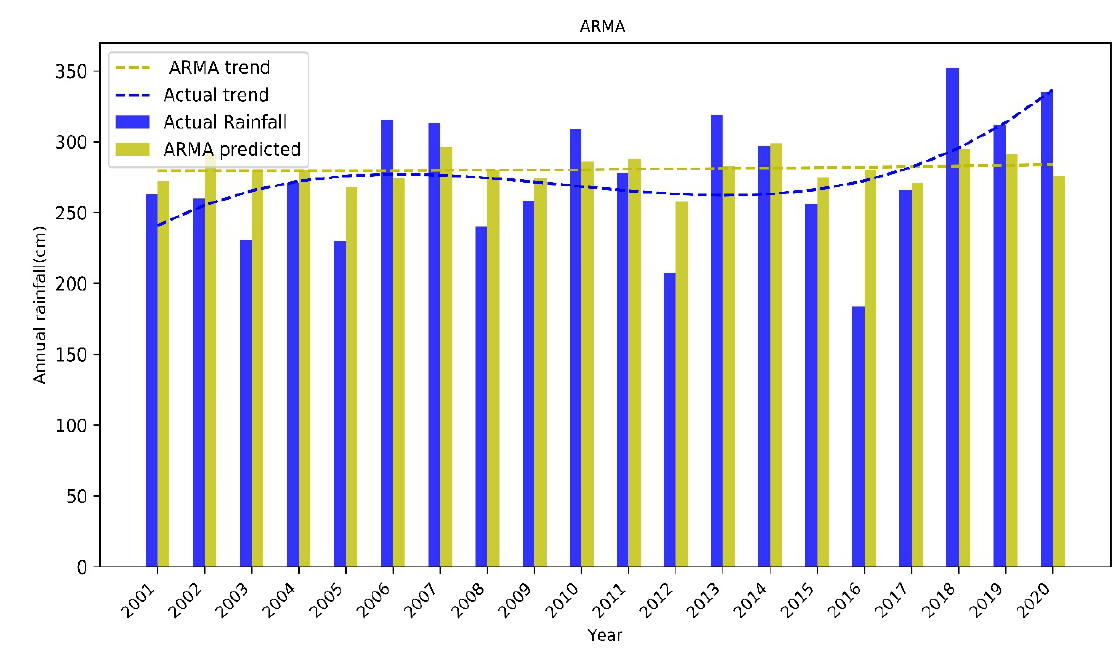
Figure 5. A bar plot of the predicted and observed annual rainfall for ARMA model (0,0,2).